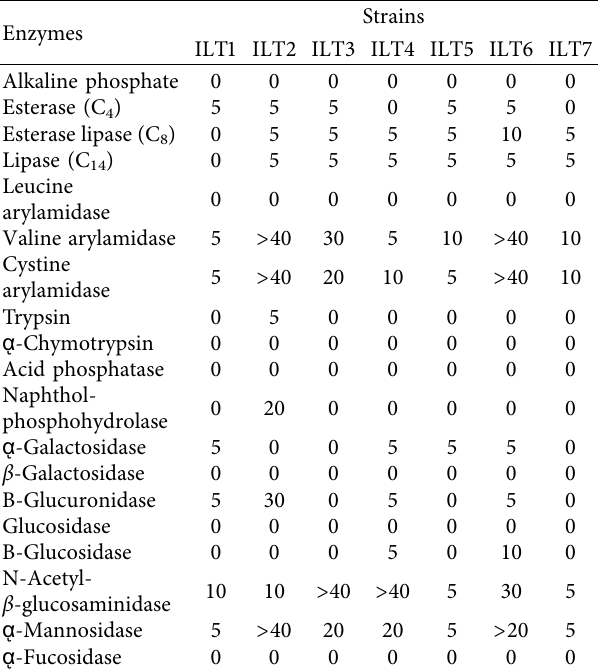
Table 4: Enzymatic activity detected using the APIZYM system of selected LAB strains.